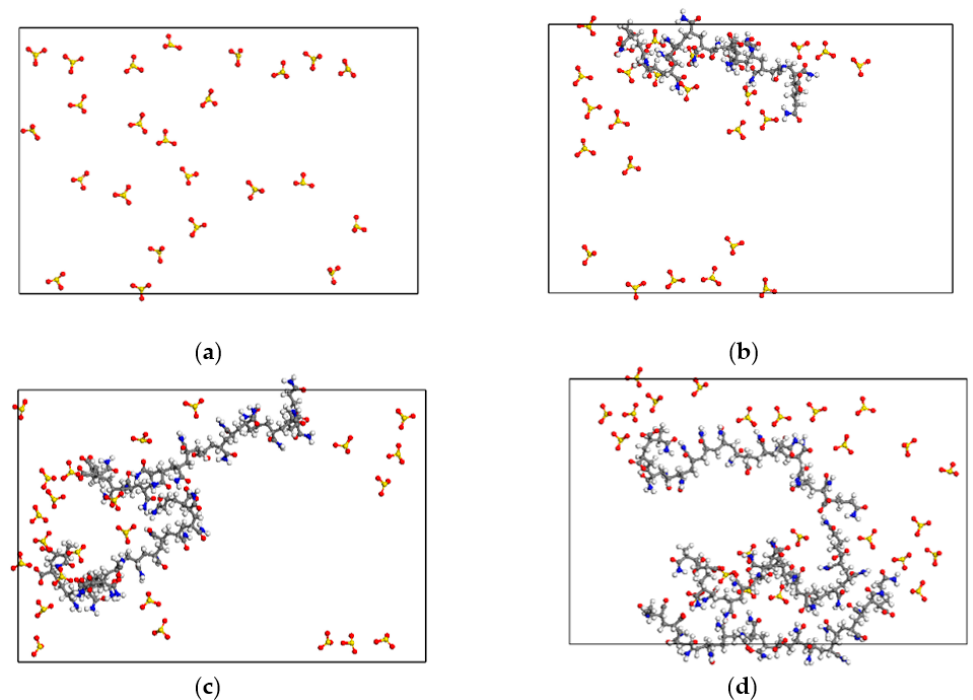
Figure 20. Sectional snapshots of the gas - liquid interface in foam systems with different HPAM concentrations after relaxation equilibrium. ( a ) “0-HPAM” system; ( b ) “1-HPAM” system; ( c ) “2- HPAM” system; ( d ) “4-HPAM” system.